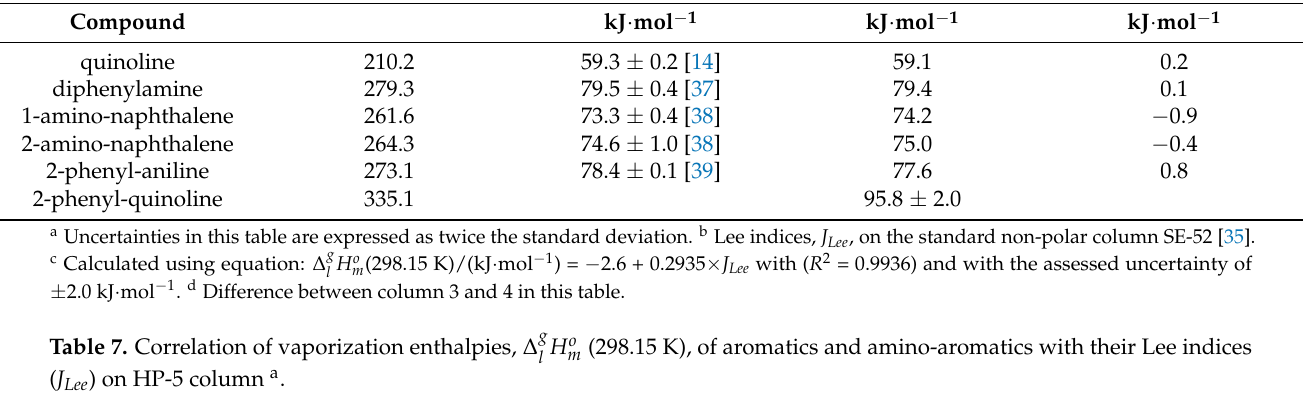
H o m (298.15 K), of aromatics and amino-aromatics with their Lee indices l